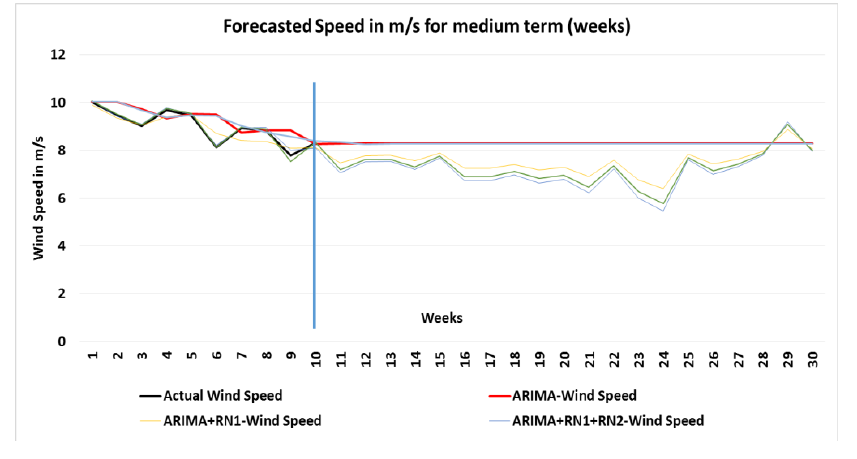
Figure 15. Forecasting of generated power in kW for medium term (weeks). Actual calculated values are until 31 May 2017, and the forecast was made from 1 June 2017, extending it 20 weeks forward. Comparing the generation results with the other horizons, it is possible to notice that the behavior varies according to the winds, even though the variations are below 10 kW, the power generation forecast was maintained at an average near 20 kW and with